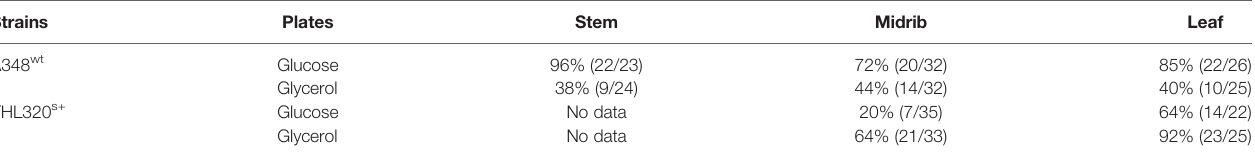
TABLE 5 | Tumor induction rate on tobacco explants co-cultivated with A348 wt and hypersensitive YHL320 s+ . Strains Plates